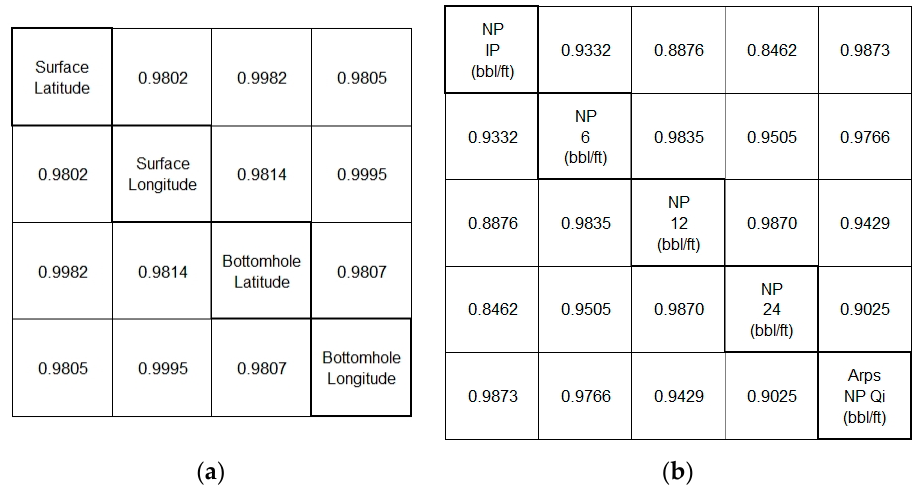
Figure 7. Highly correlated input attributes: ( a ) the attributes of the well location; ( b ) the attributes of production.